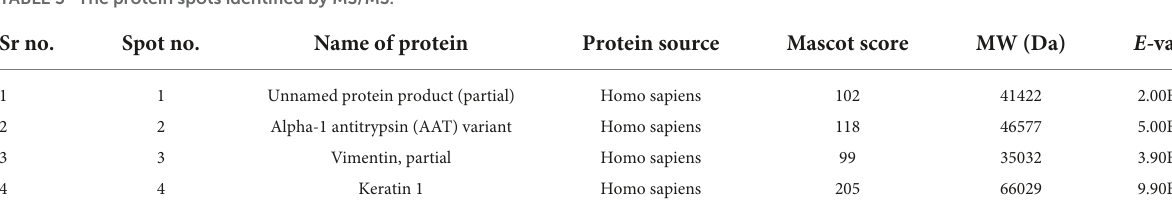
TABLE 3 The protein spots identified by MS/MS. Sr